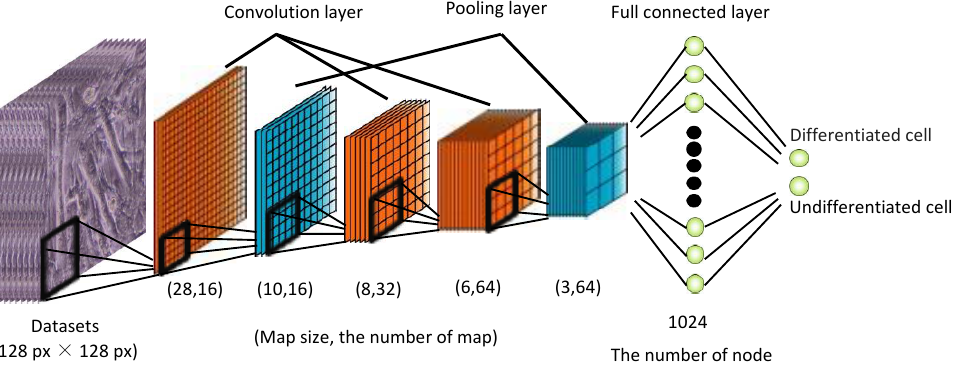
Figure 3. Architecture of the convolutional neural network model used in this study.